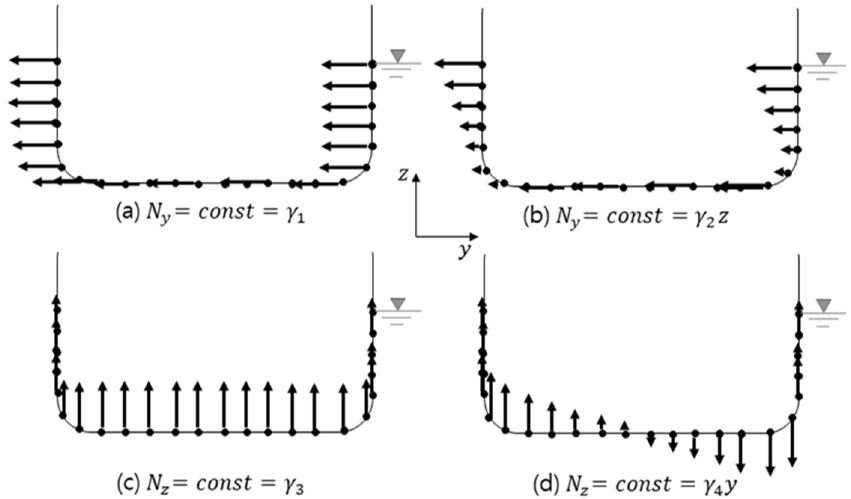
Figure 6. Nodal force distribution.